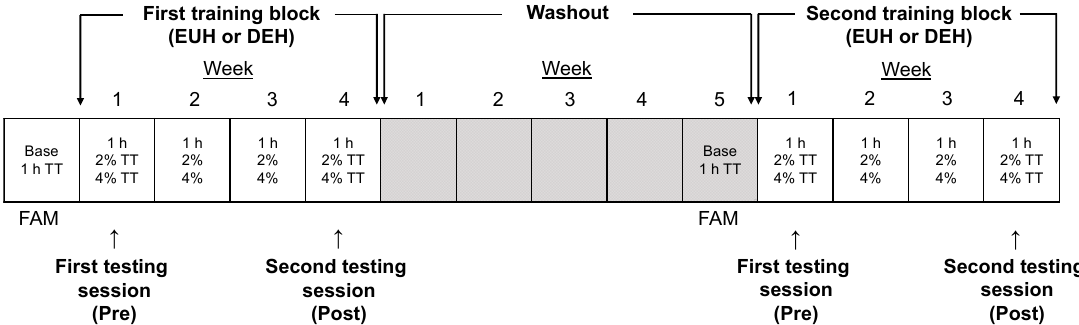
Figure 1. Experimental design of this study. FAM = familiarization session; Base = baseline measurements; 1 h TT = 1 h exercise + 12 min time-trial; 1 h = 1 h exercise bout only; 2% TT = exercise until a loss of 2% body mass has been lost or replaced + 12 min time-trial; 4% TT = exercise until a loss of 4% body mass has been lost or replaced + 12 min time-trial; EUH = euhydrated; DEH = dehydrated.